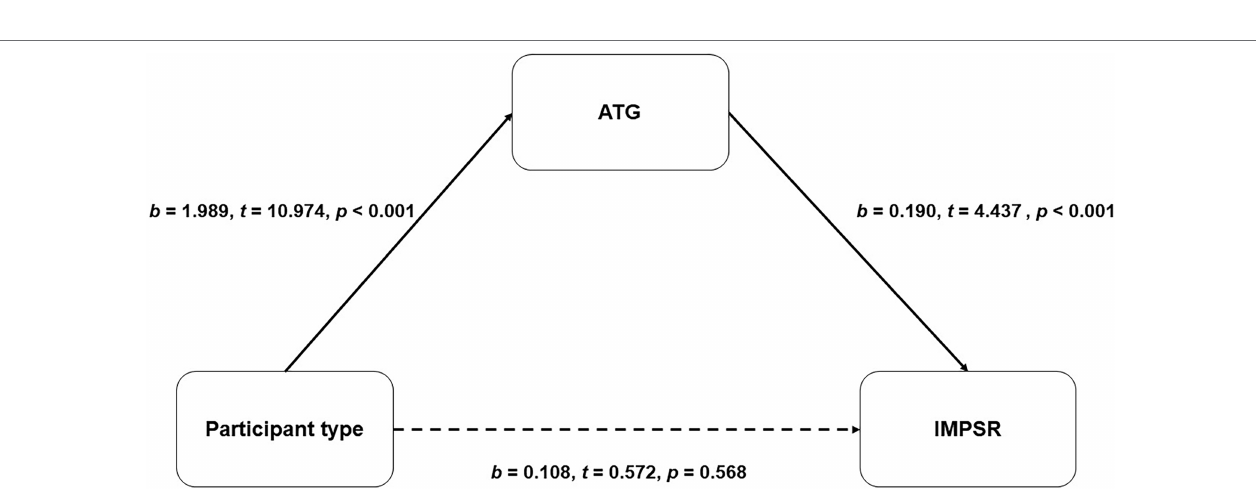
FIGURE 3 | The mediation effect of ATG between participant types and IMPSR for garners among female participants. IMPSR, ideal marriage partners similarity